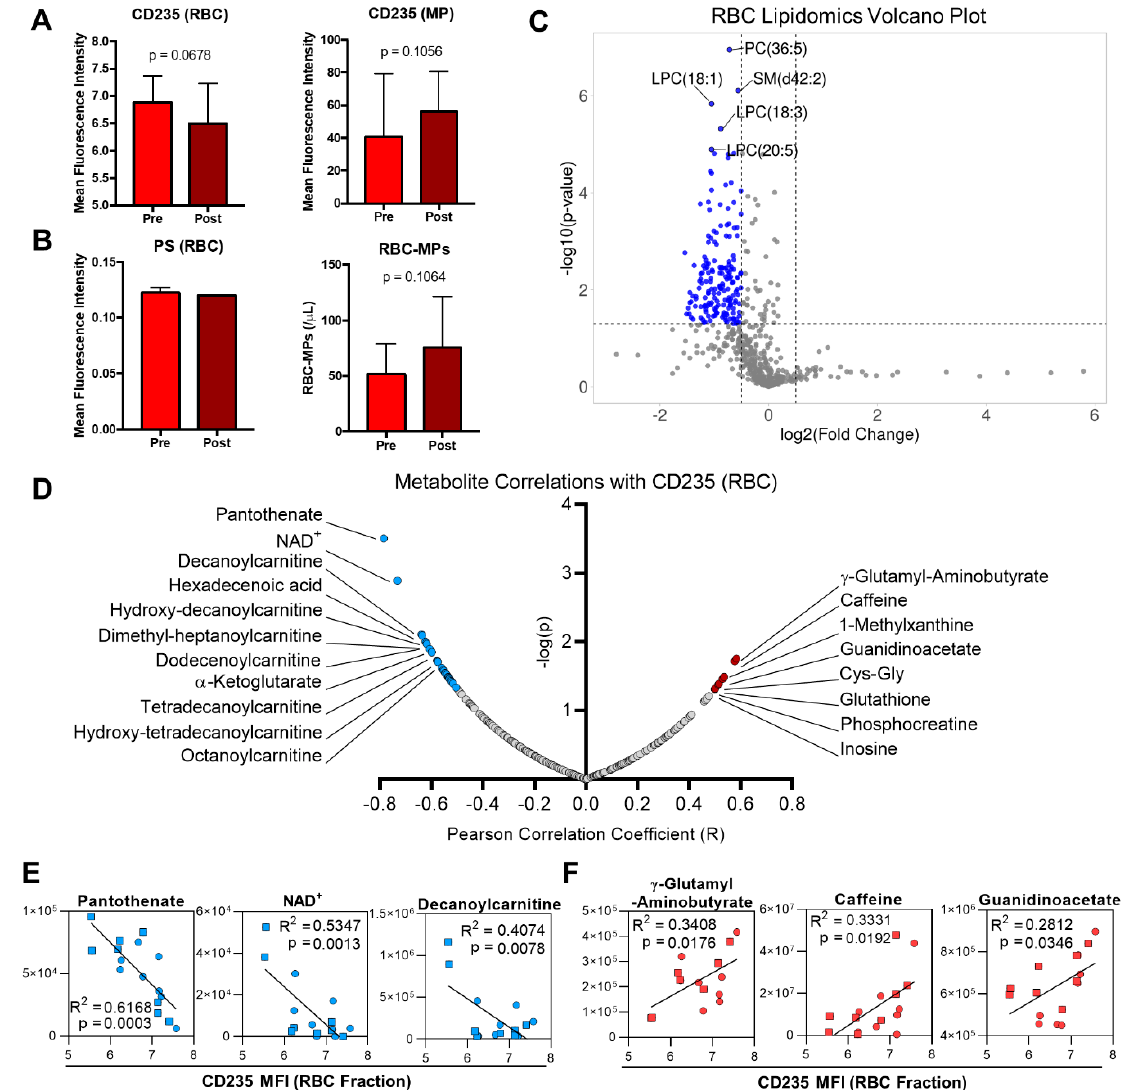
Figure 5. Red blood cell microparticle formation and associated lipid and metabolite features. ( A ) CD235 in the RBC fraction (left) and microparticle (MP) fraction (right), measured in mean fluorescence intensity (MFI) by flow cytometry. ( B ) Phosphatidylserine (PS) exposure on RBCs (left) and total RBC-MPs, quantified by co-labeling PS and glycophorin A (CD235a). ( C ) A volcano plot of global lipidomic results for RBCs is shown. Fold change was calculated as the ratio of Post/Pre values. ( D ) The top Pearson correlates with CD235 MFI in the RBC fraction. ( E ) The top three negative correlates with RBC CD235 MFI are plotted. ( F ) The top three positive correlates with RBC CD235 MFI are plotted. Values from the Pre ( ○ ) and Post ( (cid:0) ) time points are indicated. Peak areas for each metabolite are given in arbitrary units (AUs) on the y - axis.